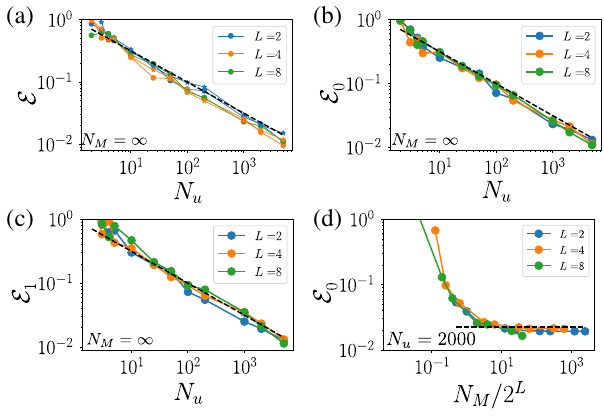
FIG. 10. Additional simulations on statistical errors. (a) Scal- ings of the error E in the estimation of O ð t Þ as a function of N u with global unitaries, and N M → ∞ . We use the two values N ¼ 4 , 8 (circles, stars). (b,c) Same as panel (a) for local unitaries estimating O 0 ; 1 ð t Þ (here, the simulations are indepen- dent of N ). (d) Statistical errors for the estimation of O 0 ð t Þ as a function of N M , and N u ¼ 2000 . In all panels, the dashed lines ffiffiffiffiffiffi N represent 1 = u